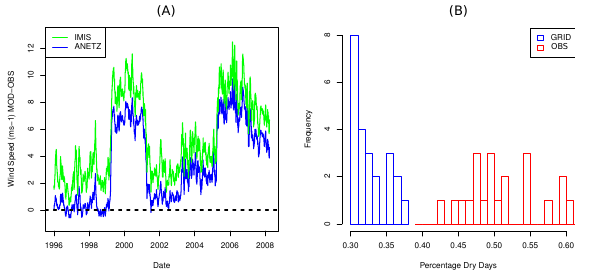
Fig. 7. Two problems encountered in the analysis. (a) Several dis- continuities were observed in the wind time series i.e period 1999– 2001 and 2005–2009. Therefore, the wind analysis was restricted to a three year period (1996–1998) that was stable. (b) A common problem with climate models is a low number of dry days which is compensated for by too high frequency and low intensity precipi- tation. The percentage dry days of OBS is much higher and distri- bution not even overlapping that of GRID data (IMIS-Data© 2013, SLF).